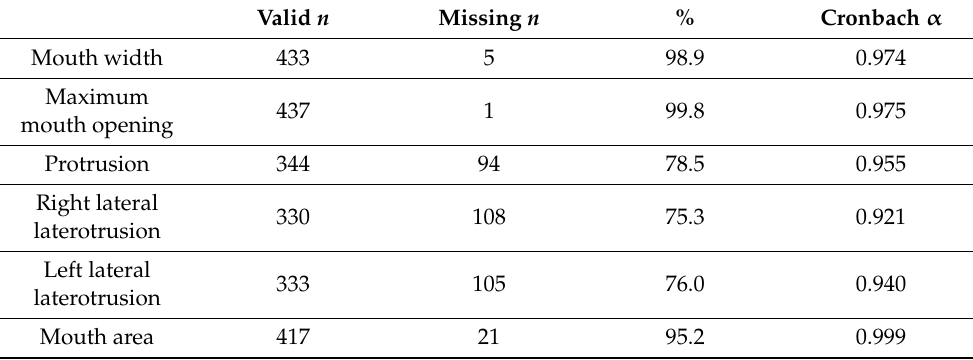
Table A1. Internal consistency of the three repeated